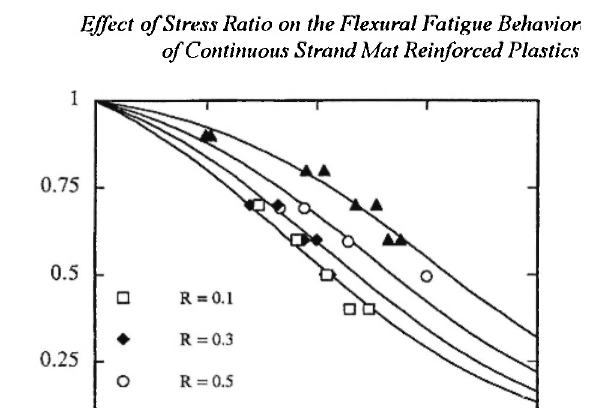
Fig. 4: Semi-log plot of non-dimensional maximum applied stress, σ ιηΗΧ /σ 0 , against the number of cycles to failure, N, for different values of stress ratio, R.